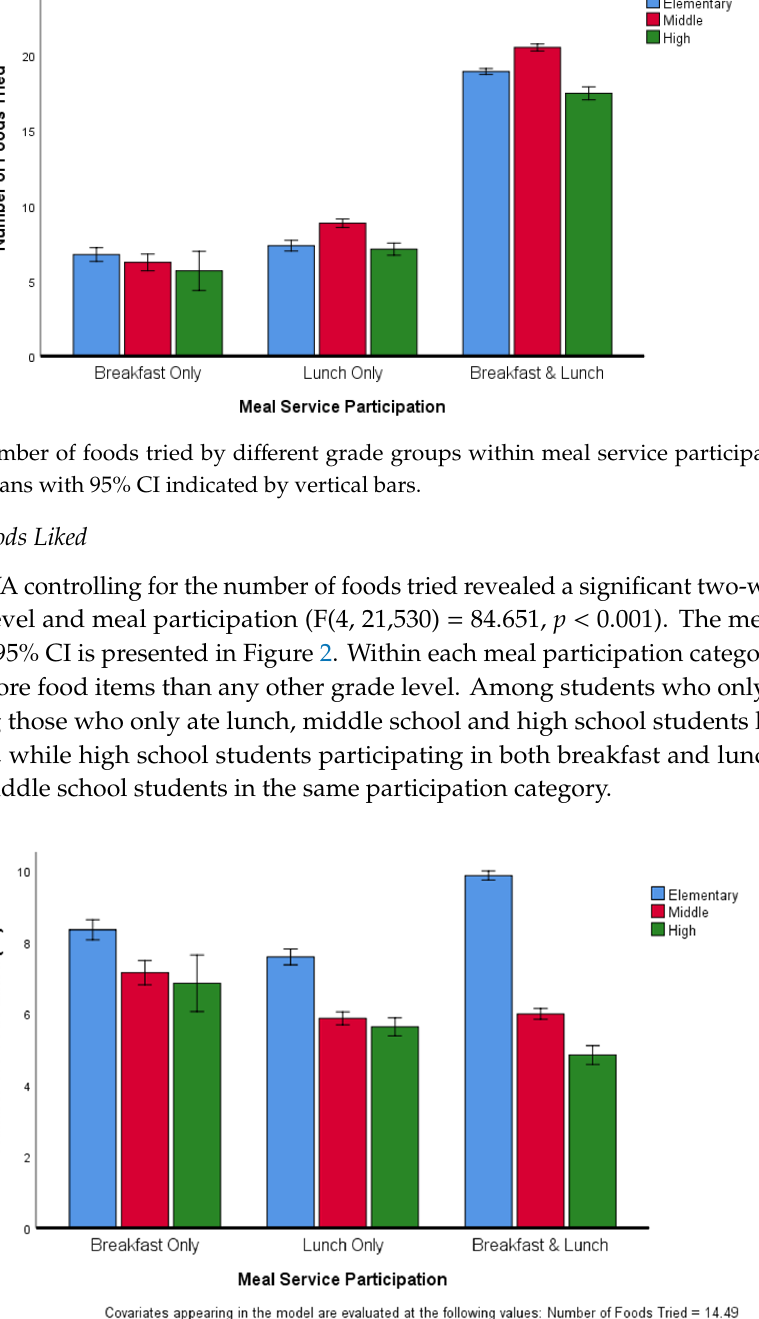
Figure 2. Number of foods liked, adjusted for number of foods tried, by different age groups within meal service participation. Values are means with 95% CI indicated by vertical bars.